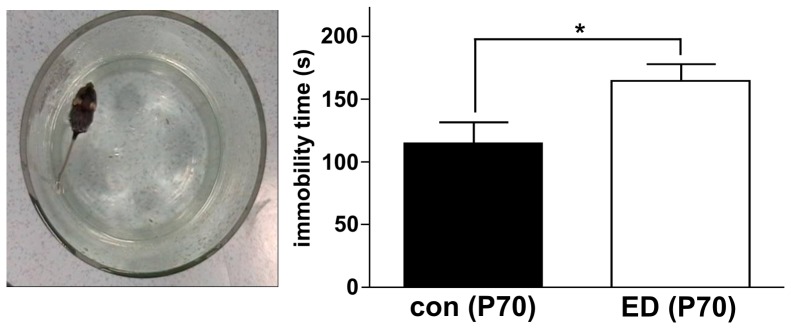
Increased immobility in the forced swimming test after early deprivation.Mice were placed in a water basin at P70 and behavior was videotaped. Immobility time represents the cumulative time spend with passive floating from minute 2 to 6 after the start of the experiment. Immobility time was significantly increased in adult mice which had been deprived after birth (n = 9 each).